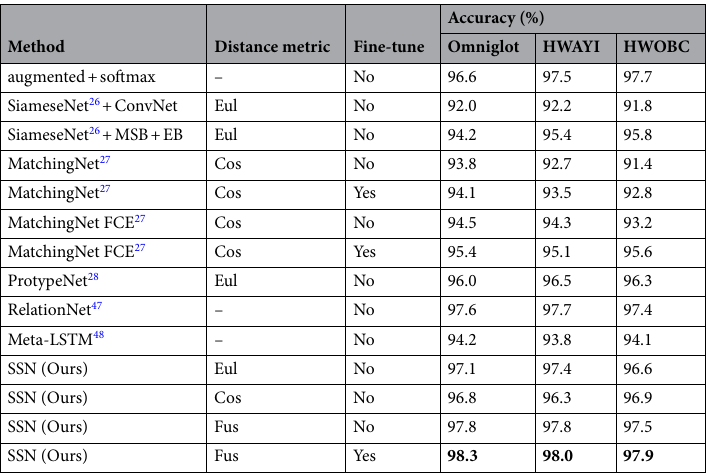
Table 5. The comparison experiments. (Except for our benchmark derived from the original paper, the other results are from the reproduced 20-way one shot classification with the best accuracy). “Eul.”: Euclidean distance. “Cos.”: Cosine distance. “Fus.”: Fusion distance of our SSN. “No” means that no test set categories will be used to assist in training the model, while “Yes” means that test set categories will be used to assist in training the model. Significant values are in